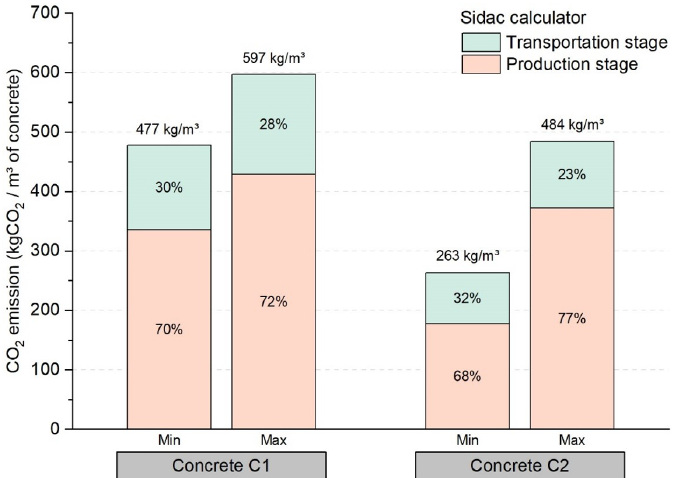
Figure 7. Minimum and maximum CO 2 emissions from C25 concrete estimated using the Sidac calculator and its